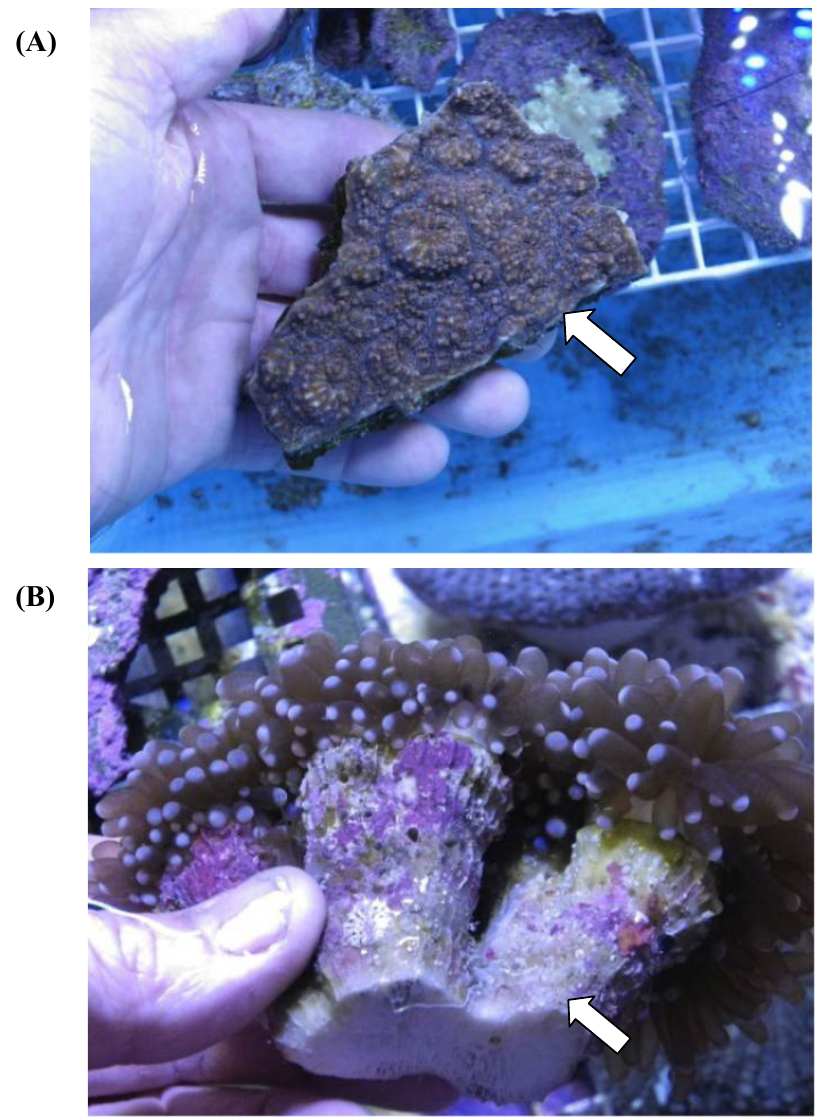
Figure 5. Specimens of two species targeted by the Queensland Coral Fishery ( A ) Echinophyllia divisa (chalice coral) and ( B ) Euphyllia glabrescens (torch coral) showing evidence of fragmentation (arrows) by an implement such as a bone